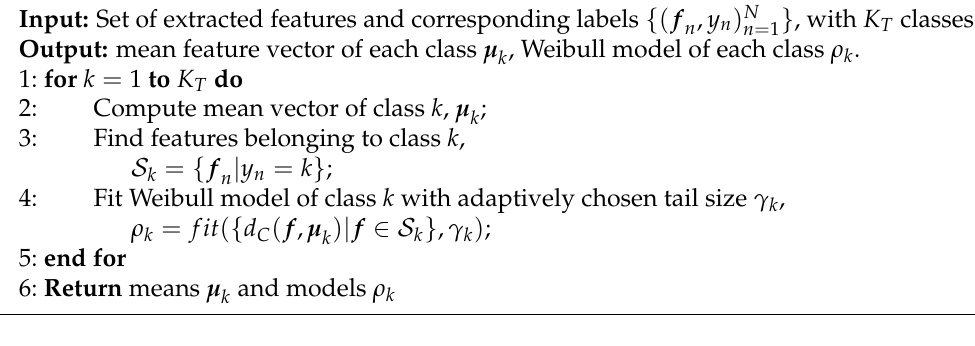
Algorithm 1 The training algorithm for adaptive class-wise